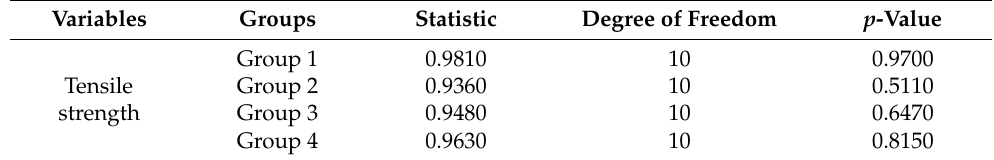
Table 4. Normality test of tensile strength scores in four groups by Shapiro–Wilk test. Variables Groups Statistic Degree of Freedom p -Value Group 1 0.9810 10 0.9700 Tensile Group 2 strength